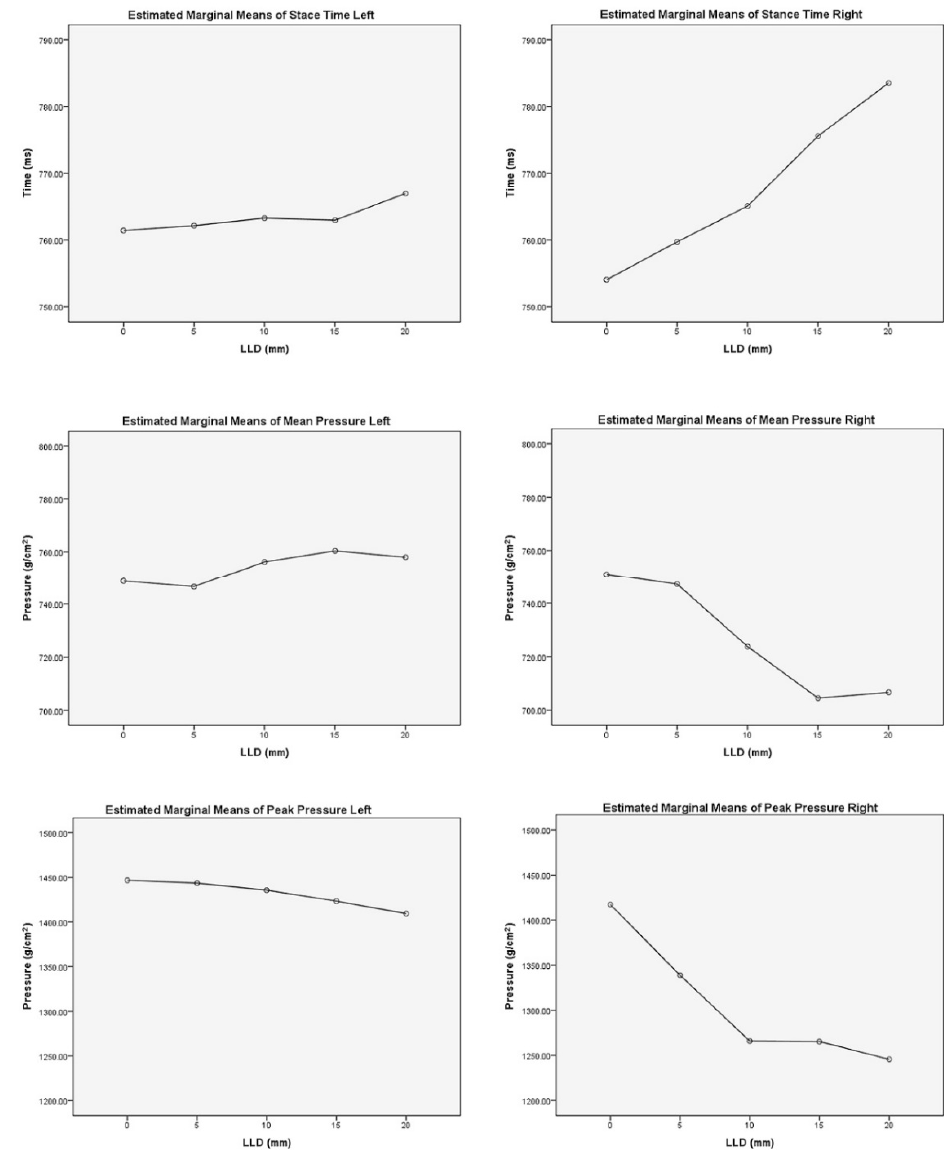
Figure 2. Estimated marginal means of stance time, mean pressure and peak pressure.